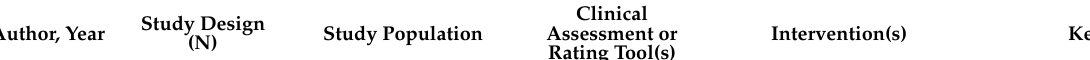
Table 1. Studies reviewed (arranged alphabetically by first author’s last